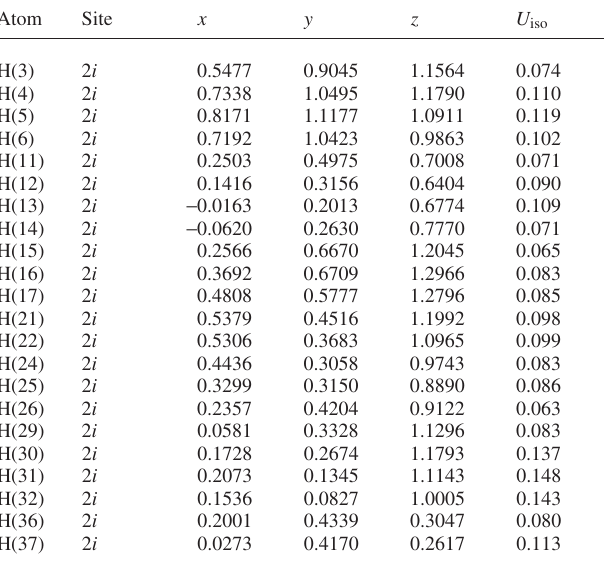
Table 2. Atomic coordinates and displacement parameters (in Å 2 )